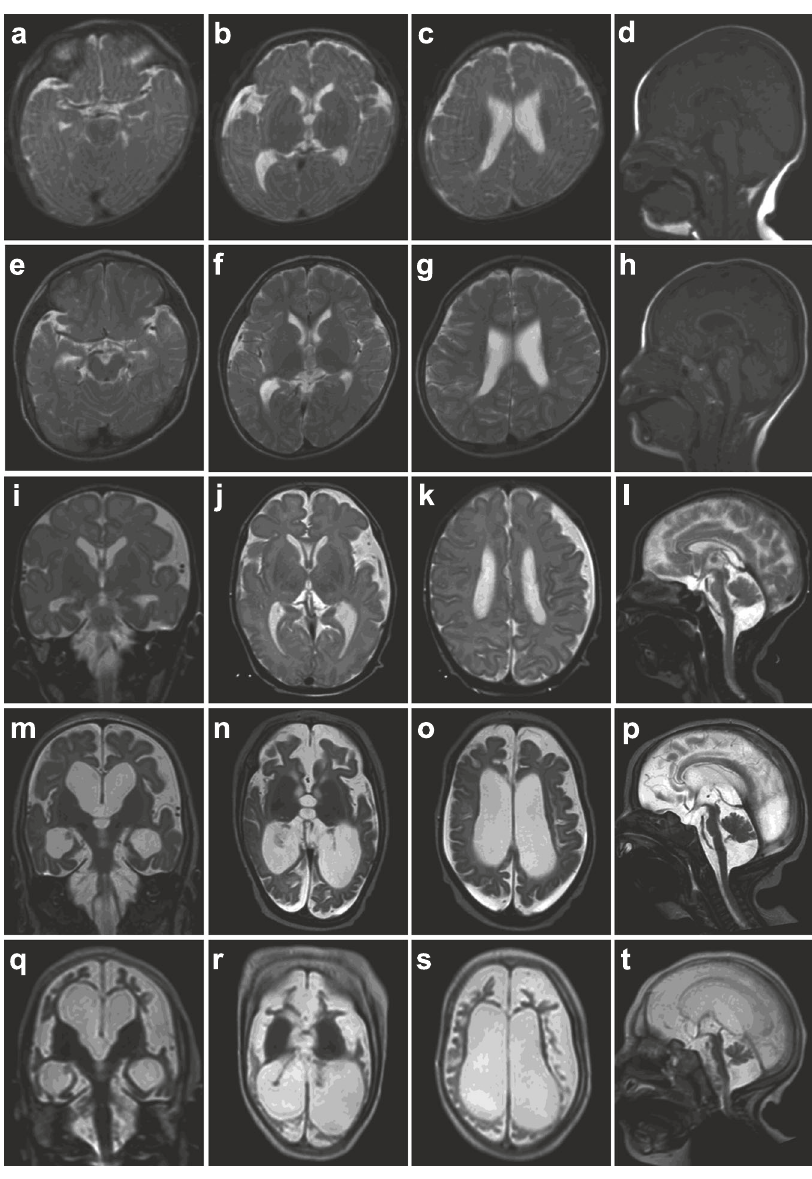
Fig. 2 Brain MRI of individuals with the ATP6V0A1 variant. Individual 2 at 6 months ( a – d ) and at 4 years of age ( e – h ), and individual 3 at 10 days ( i – l ), 6 months ( m – p ), and 3 years of age ( q – t ). All images are T2-weighted except for d and h , which are T1-weighted. Axial images of individual 2 ( a – c , e – g ) show mildly enlarged lateral ventricles, which did not change in size between 6 months and 4 years. Sagittal images of individual 2 ( d and h ) show a mildly enlarged third ventricle, which was not progressive, and the cerebellum and brainstem are normal. Individual 3 shows progressive atrophy of the cerebrum, including the hippocampi and cerebellum associated with enlarged sulci, ventricles, and subarachnoidal space. The cerebellum of individual 3 showed hypoplasia at 10 days ( l ). Basal ganglia and brainstem except the pontine basis are relatively